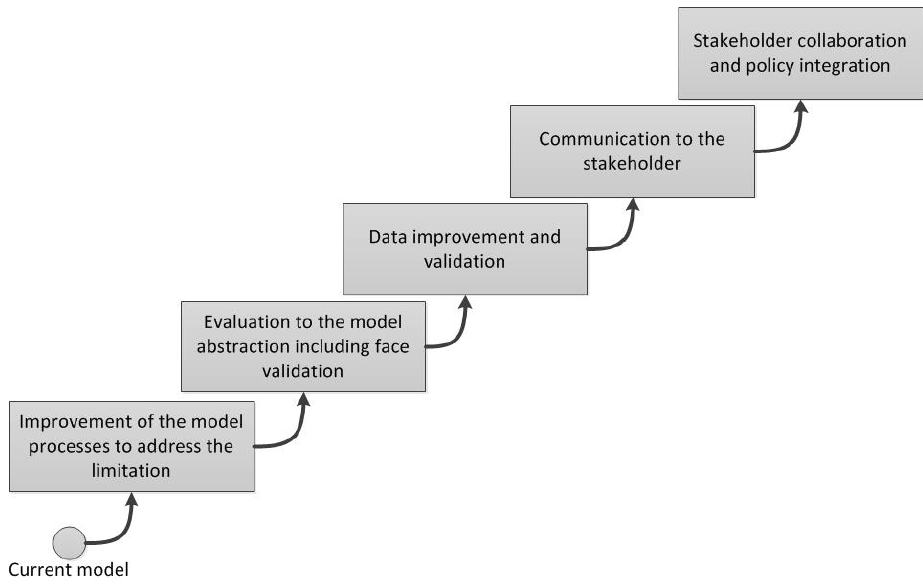
Figure 13. Road map of model implementation – leading to policy integration.